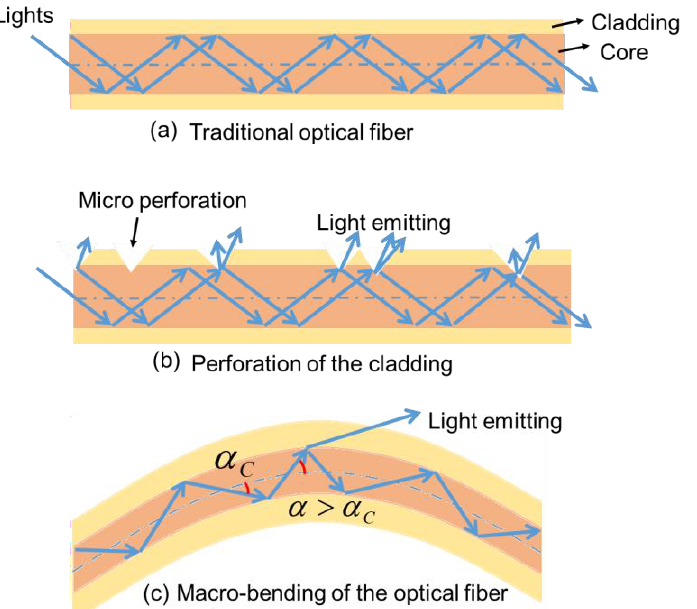
Figure 1. Principle of lateral light emission: ( a ) traditional optical fiber; ( b ) perforation of the cladding; ( c ) macro-bending of the optical fiber.